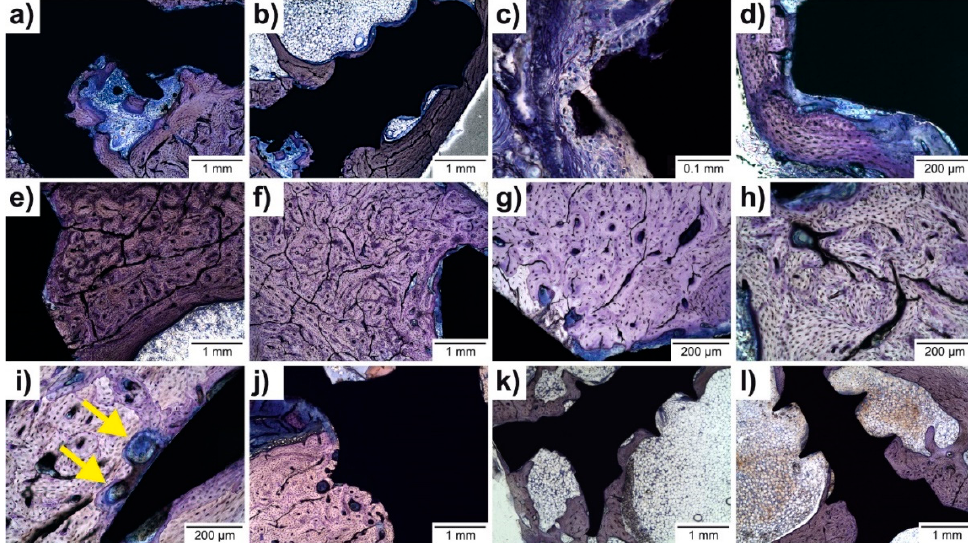
Figure 7. Histological examination of bone specimens ( a – f ) 120 days after experimental screw implantation; ( g , h ) 240 days after experimental Zn-based screw implantation; ( i , j ) 360 days after experimental screw implantation. Mild changes in the experimental screw sharpness, suggesting possible corrosion ( k , l ) 360 days after Ti-based screw implantation. Osteon-like cavities—arrows. Figure 7a,c,d are assumed from our previous pilot study